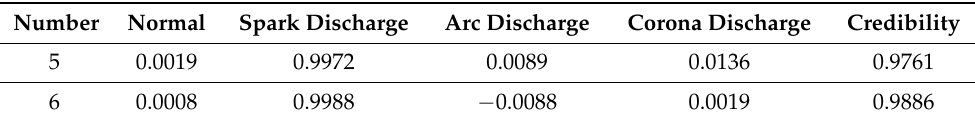
Table 11. The diagnosis results of the updated neural network model.